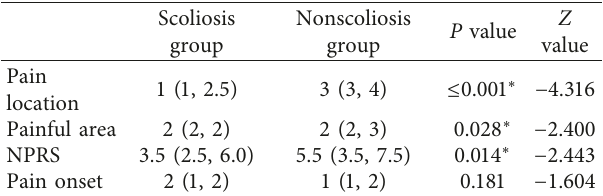
Table 2: Descriptive statistics of description of the low back pain in two